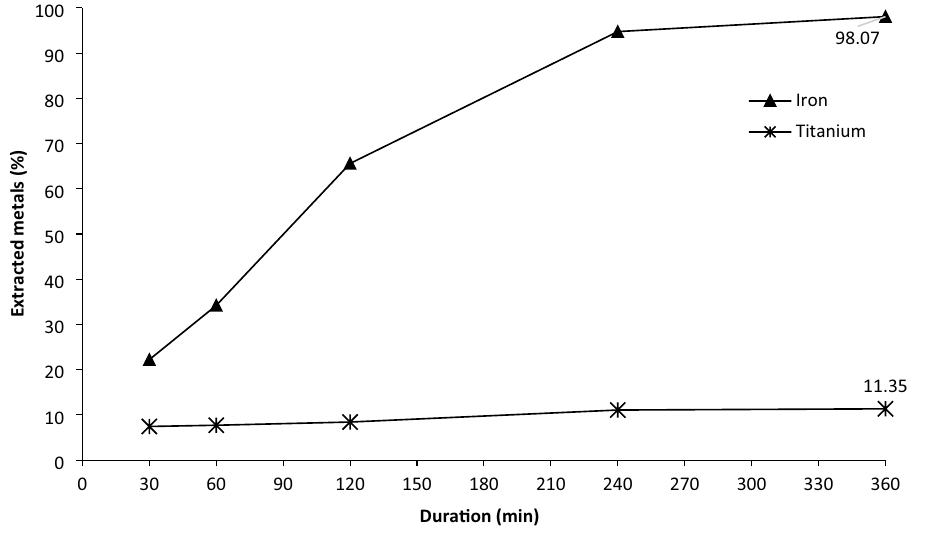
Figure 7. Profiles of extracted iron and co-extracted titanium during the leaching of pre-oxidised ilmenite at the optimum condition: [HCl] = 6 M, T = 80 °C, S/L = 1/20 g/ml, size fraction = 44–74 µm, duration = 6